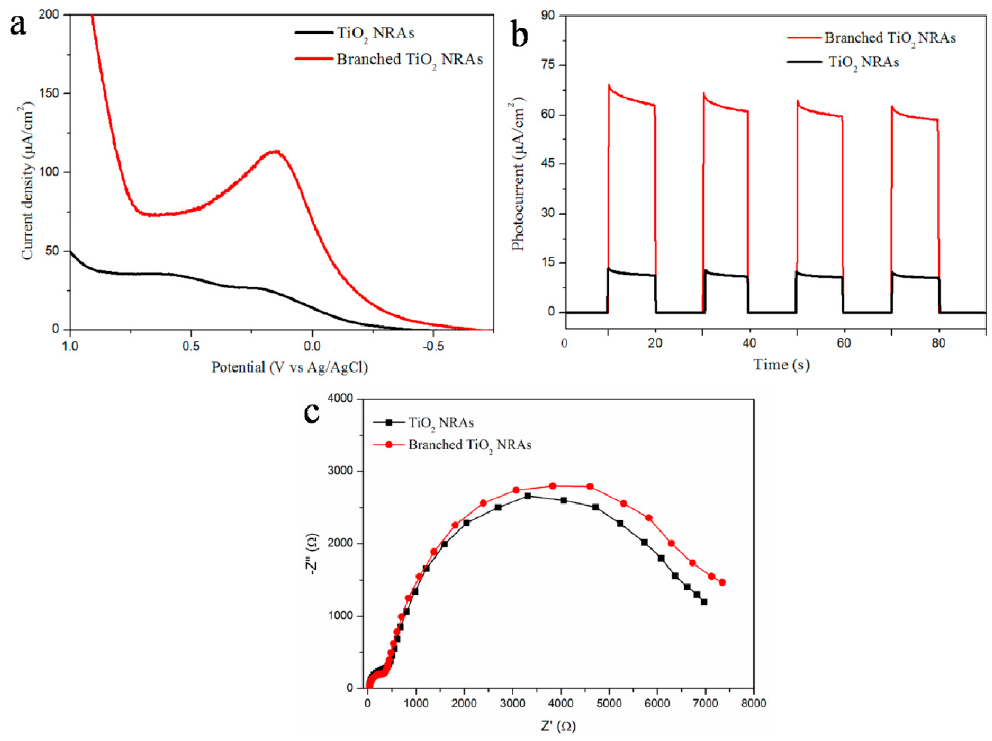
Figure 6. ( a ) Current-density versus voltage ( J - V ) curves and ( b ) photocurrent density response of TiO 2 NRAs and branched NRAs; ( c ) Nyquist plots of TiO 2 NRAs and branched NRAs based cells.